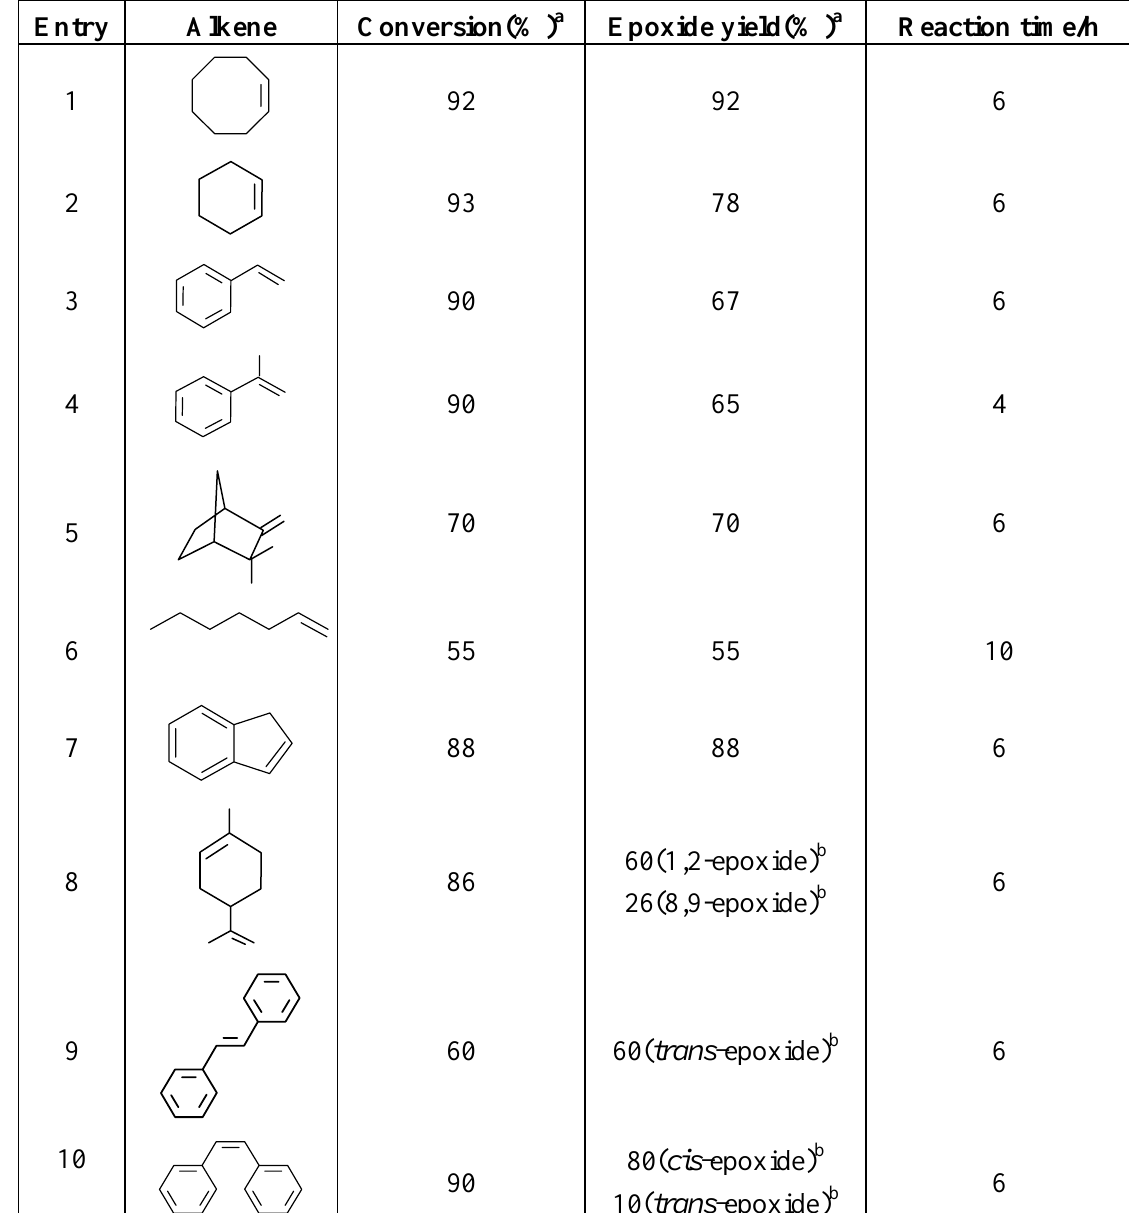
Table 1: Epoxidation of alkenes with NaIO the presence of imidazole at room